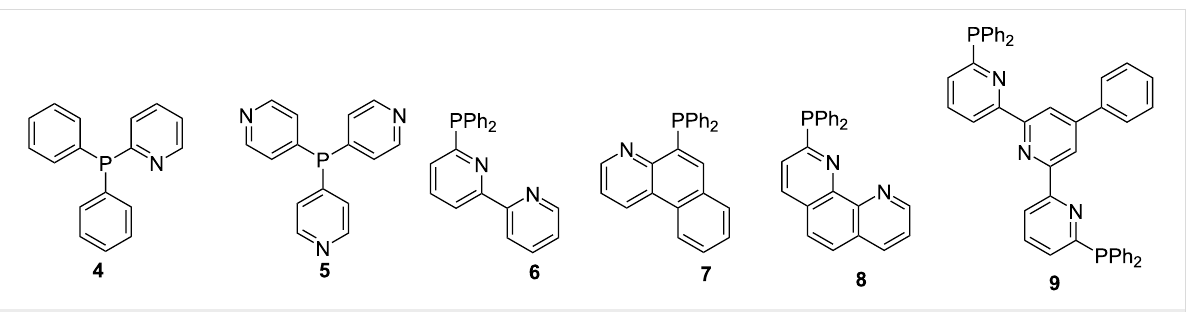
Figure 1: Pyridylphosphine